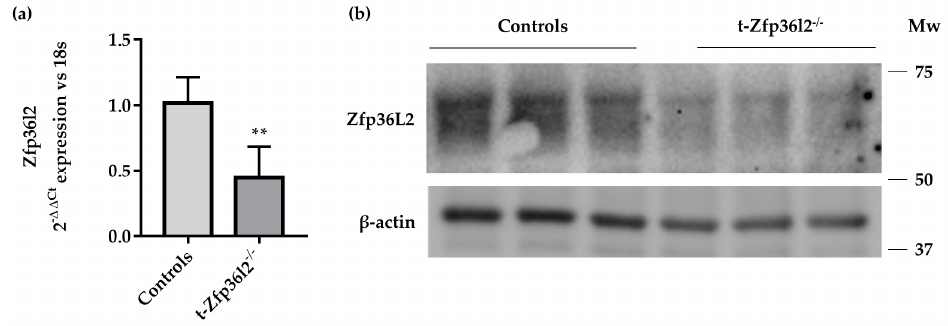
Figure 2. Molecular validation of the t − Zfp36l2 -/- mice. Analysis of ( a ) Zfp36l2 mRNA by RTqPCR and ( b ) protein by Western blotting was conducted on extracts from thyroid samples of the control ( n = 3) and t − Zfp36l2 -/- ( n = 3) mice. RTqPCR data are reported as mean ± standard deviation of ∆∆ Ct values (FC values of gene normalized vs. FC values of 18SrRNA to obtain ∆ Ct values of samples; ∆ Ct values of KO samples are then normalized vs. ∆ Ct of Control samples to obtain ∆∆ Ct values) in KO ( n = 3) and control mice ( n = 3); ** p < 0.01.